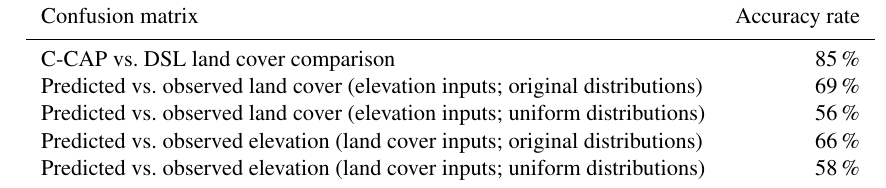
Table 1. Summary table of accuracy rates for all confusion matrices of land cover and elevation comparisons. Accuracy rates are calculated by summing where predictions matched observations (the diagonal bolded terms in Tables S2–S4) and dividing by the total number of outcomes. Confusion matrices are available in the Supplement (Tables